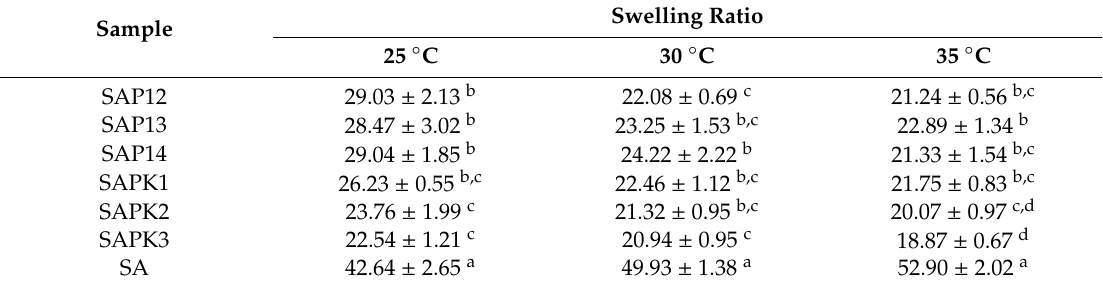
Figure 5. Swelling ratio of beads with different compositions at different temperatures (different letters in the graph indicate significant differences in swelling ratio of the beads at different temperatures using Duncan’s multiple tests). Table 3. Swelling ratio of beads with different compositions at different temperatures (the marked letters indicate significant differences in swelling ratio of the beads with different compositions at the same temperature), “ a, b, c ” different letters in the same series indicate significant difference at p ﹤ 0.05.